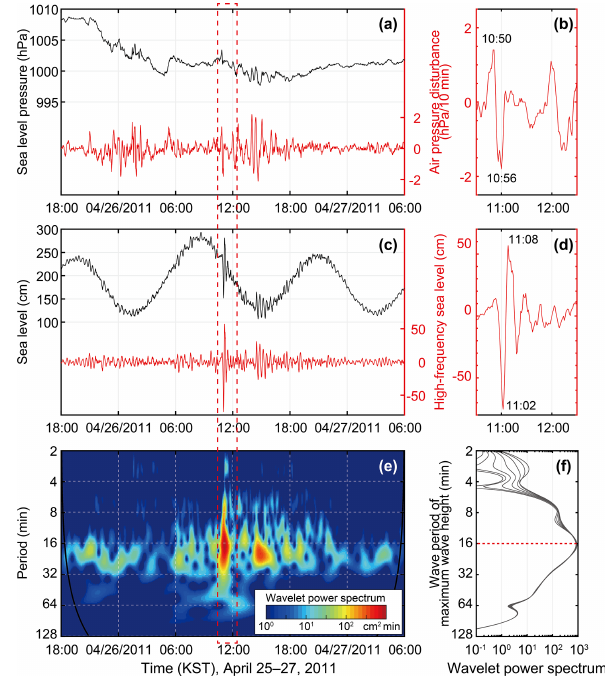
Figure 2. Characteristics of the pressure-forced meteotsunami from the Daeheuksando (DH) harbor during the 26 April 2011 meteot- sunami event: (a) 36h record of sea-level pressure and air pressure disturbances, (b) 2h record of air pressure disturbances for clar- ity, (c) 36h record of sea level and high-frequency sea level, (d) 2h record of high-frequency sea level for clarity, (e) wavelet power spectrum for the high-frequency sea level, and (f) wave period es- timated from the maximum wavelet power spectrum (red dashed line) during the maximum wave height. The time of the destructive meteotsunami accident is highlighted by the red dashed